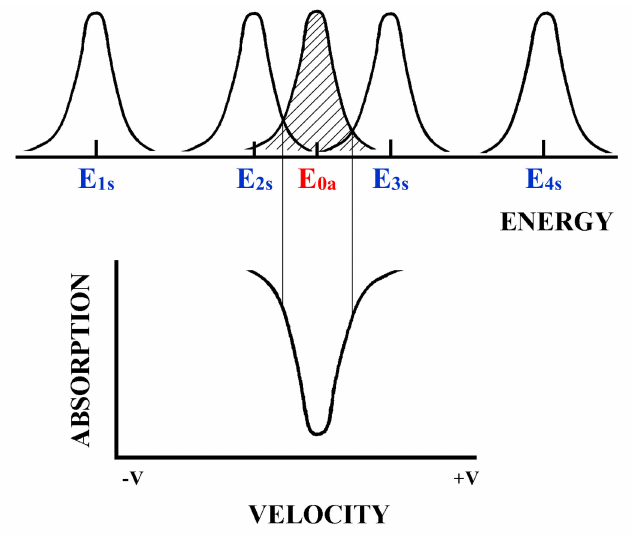
Figure A3. Achieving γ -resonance absorption using Doppler modulation of γ -rays energy E is = E 0s (1 ± V i /c), open lines are emitted γ -ray lines with energy modulation by velocity and dashed line is absorption γ -ray line. Observation of the Mössbauer